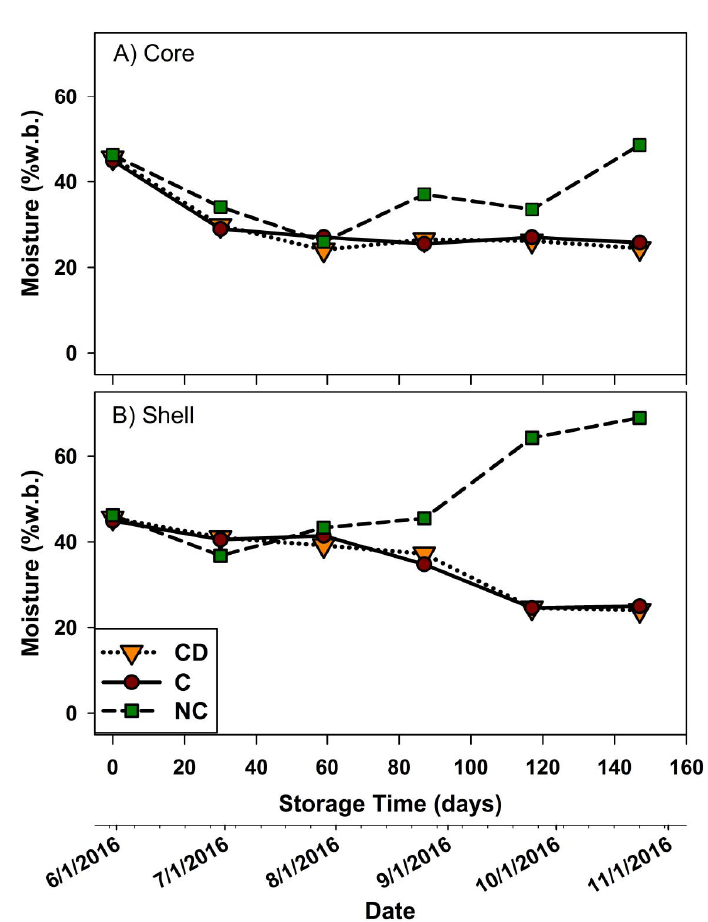
Figure 4. Variation of the moisture content of willow and poplar wood chips stored for five months in piles with three di ff erent treatments (NC—no cover on pile; C—covered pile; CD—covered pile with dome ventilation); A) samples from the core; B) samples from the shell.